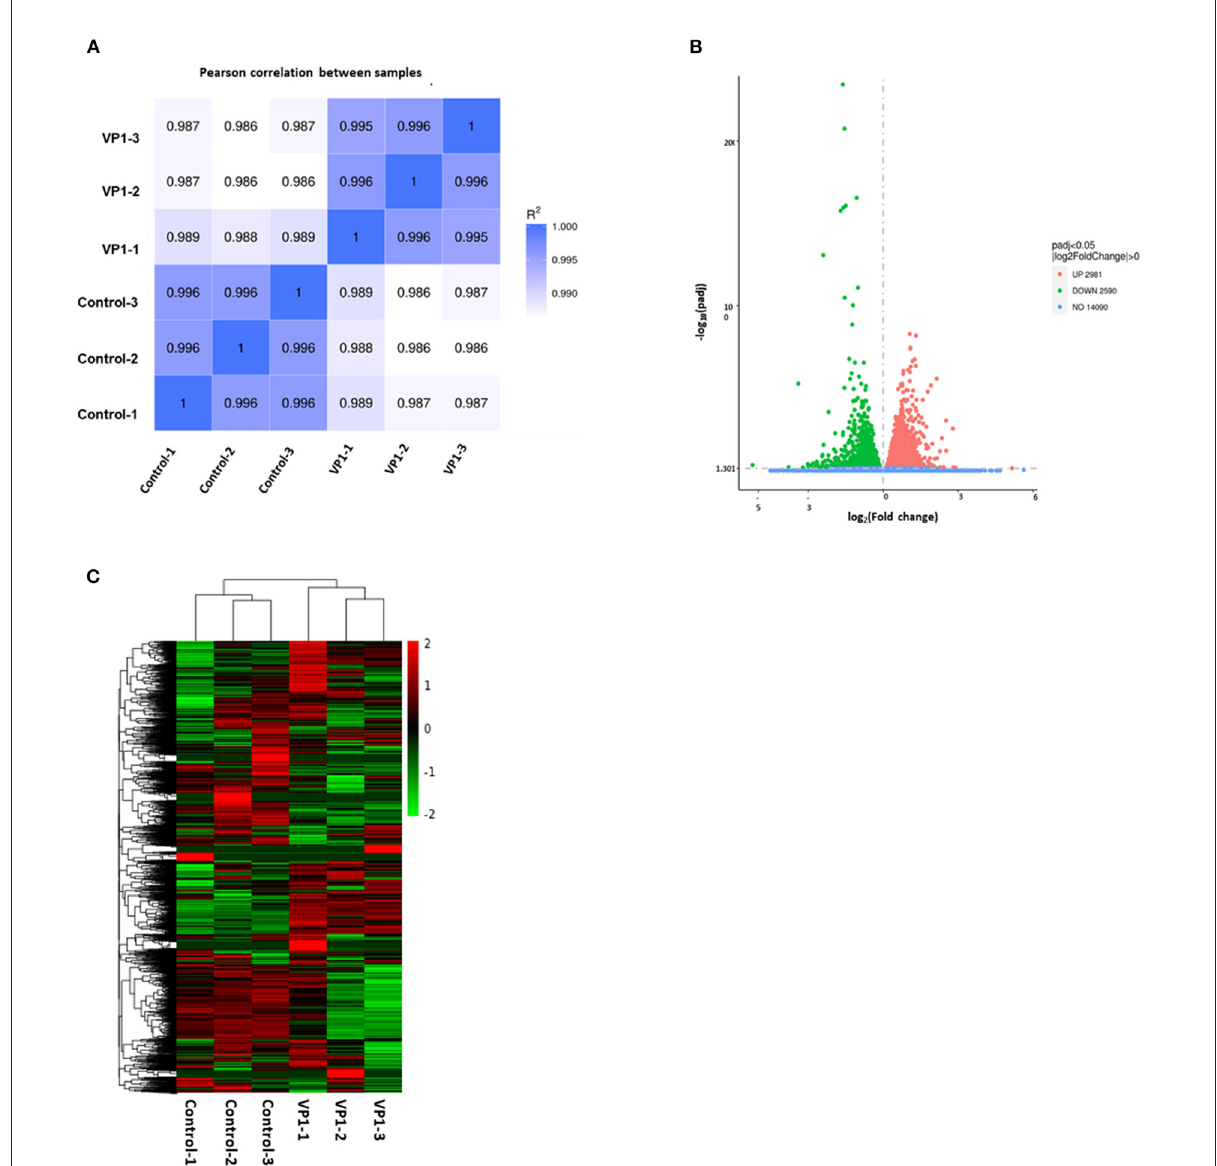
FIGURE2 Quality control of samples and quantitative analysis of differentially expressed genes (DEGs). (A) Sample correlation heat map. The shades of color and numbers represent Pearson’s correlation coefficient (R) values, indicating sample repeatability in the same group. (B) Volcano plots of the distribution of DEGs. The x-axis represents the fold change (log2Fold Change) of gene expression between the VP1 and control group, and the y-axis indicates the significance level (-log10padj) of gene expression difference. The dot diameter represents expression levels of DEGs which are either up-regulated (red) or down-regulated (green). And blue dots represent non-significantly regulated genes. (C) Differential gene cluster map. The x-axis in the figure is the sample name, and the y-axis is the value after the normalization of differential gene FPKM. The color scale represents gene expression abundance, with red representing more pronounced up-regulation and green representing more pronounced down-regulation.